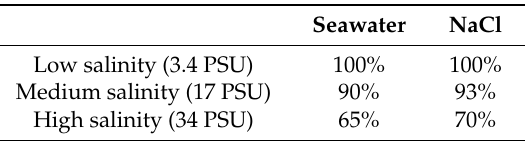
Table 2. The measured GAL activity when sewage was diluted in water with increased salinity, relative to low salinity (set to 100%). Increased salinity was obtained by diluting sewage in sterile deep seawater from Oslofjord (seawater) or from adding NaCl to distilled